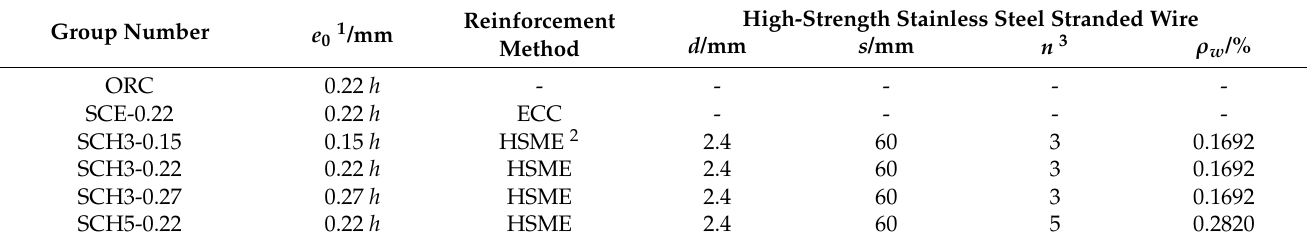
Table 1. Test parameters of specimens.